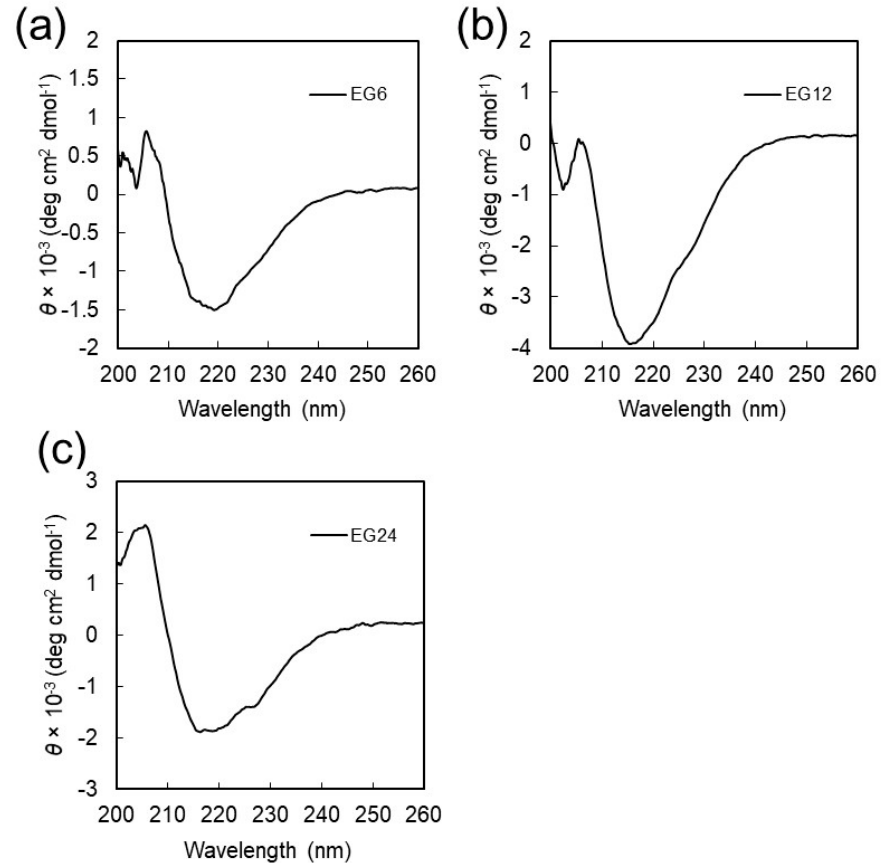
Figure 4. CD spectra of EG n NFs measured in PBS at room temperature. The EG n NFs were prepared by incubation of EG n peptide solutions in PBS at 60 °C for 24 h. ( a ) EG 6 NFs, ( b ) EG 12 NFs, and ( c ) EG 24 NFs.